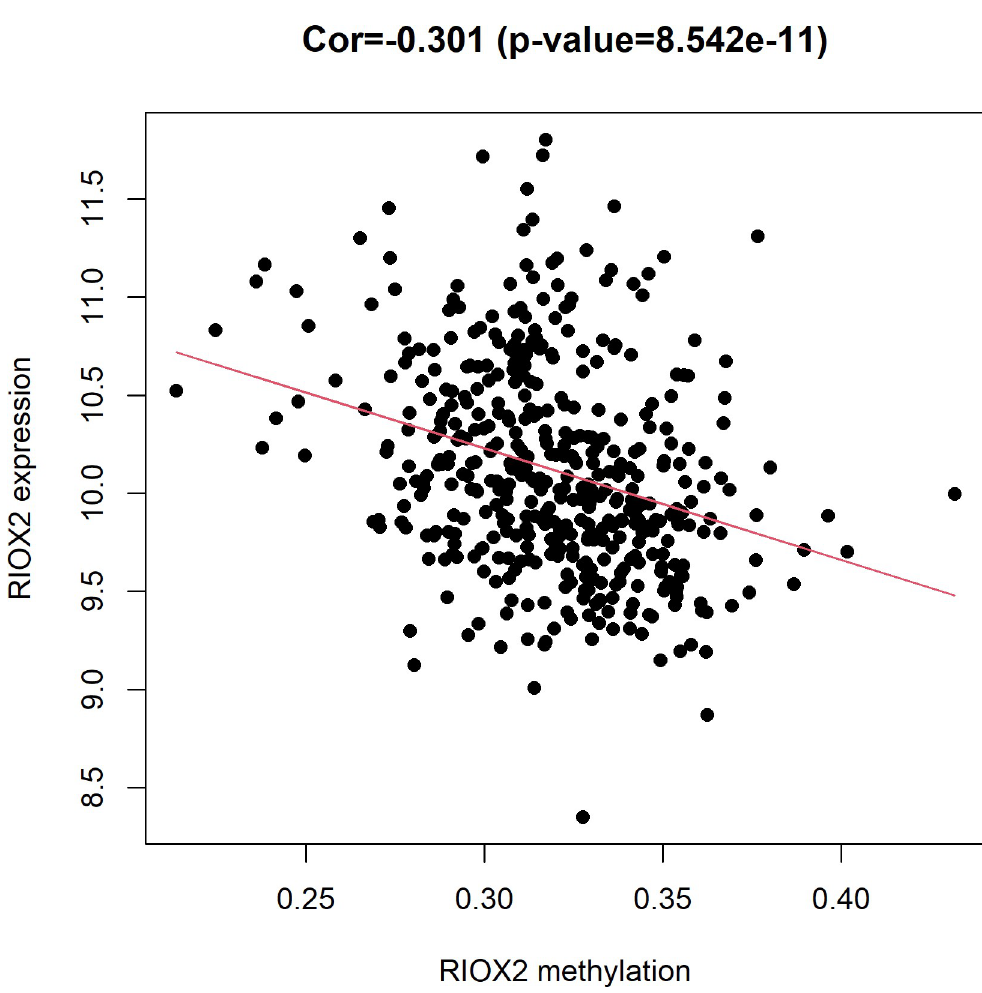
Fig 2. The relationship between RIOX2 gene expression and methylation levels in lung adenocarcinoma. The horizontal coordinate is the RIOX2 methylation level, and the vertical coordinate is the RIOX2 gene expression